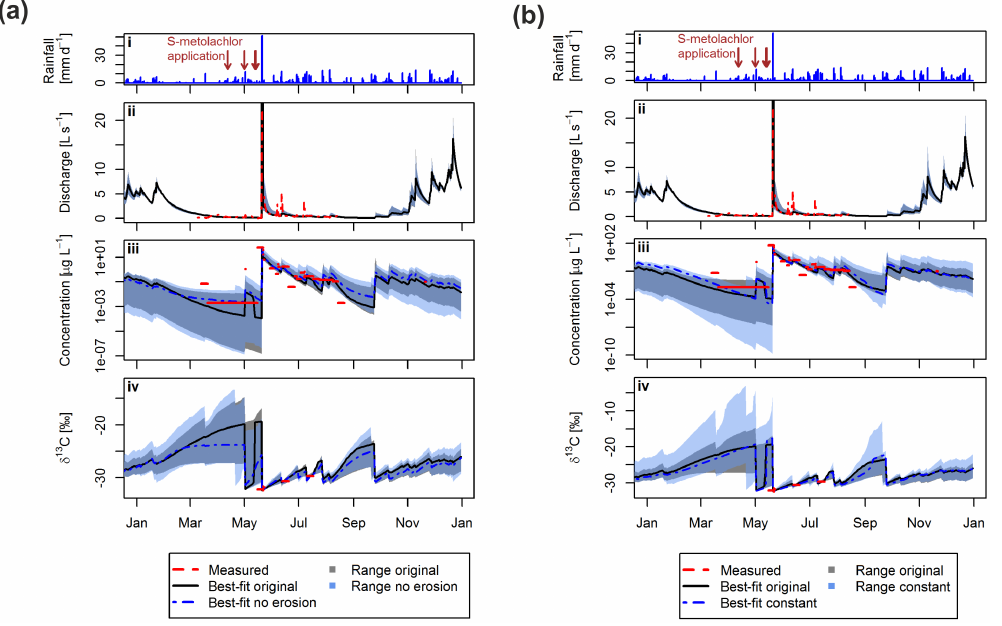
Figure 6. Comparison between the original model and modified model setups: without erosion (a) and with a constant degradation half-life in the transport zone (b) , respectively. Measured (red lines) and modelled time series are given for discharge ( a ii and b ii), S-metolachlor concentrations ( a iii and b iii; note the log-scaling), and δ 13 C values ( a iv and b iv) in 2012. Best-fit simulations for the modified and original model setups are indicated as dashed blue and solid black lines, respectively. Shaded areas show the range between the 5th and 95th per- centiles of 1000 calibration runs with the modified models (transparent blue) and 10000 calibration runs with the original model (dark grey), respectively. Blue bars in ( a i and b i) indicate daily precipitation and brown arrows indicate the dates of pesticide